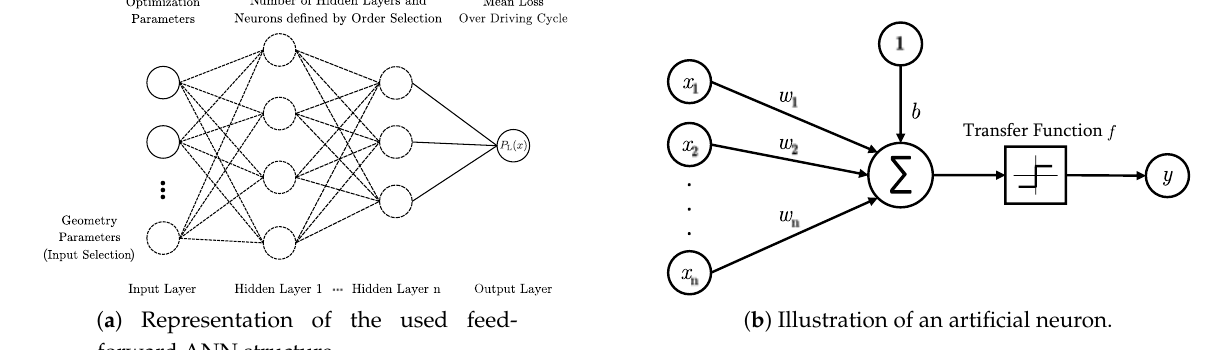
Figure 2. Representation of the used feed-forward ANN and artificial neuron